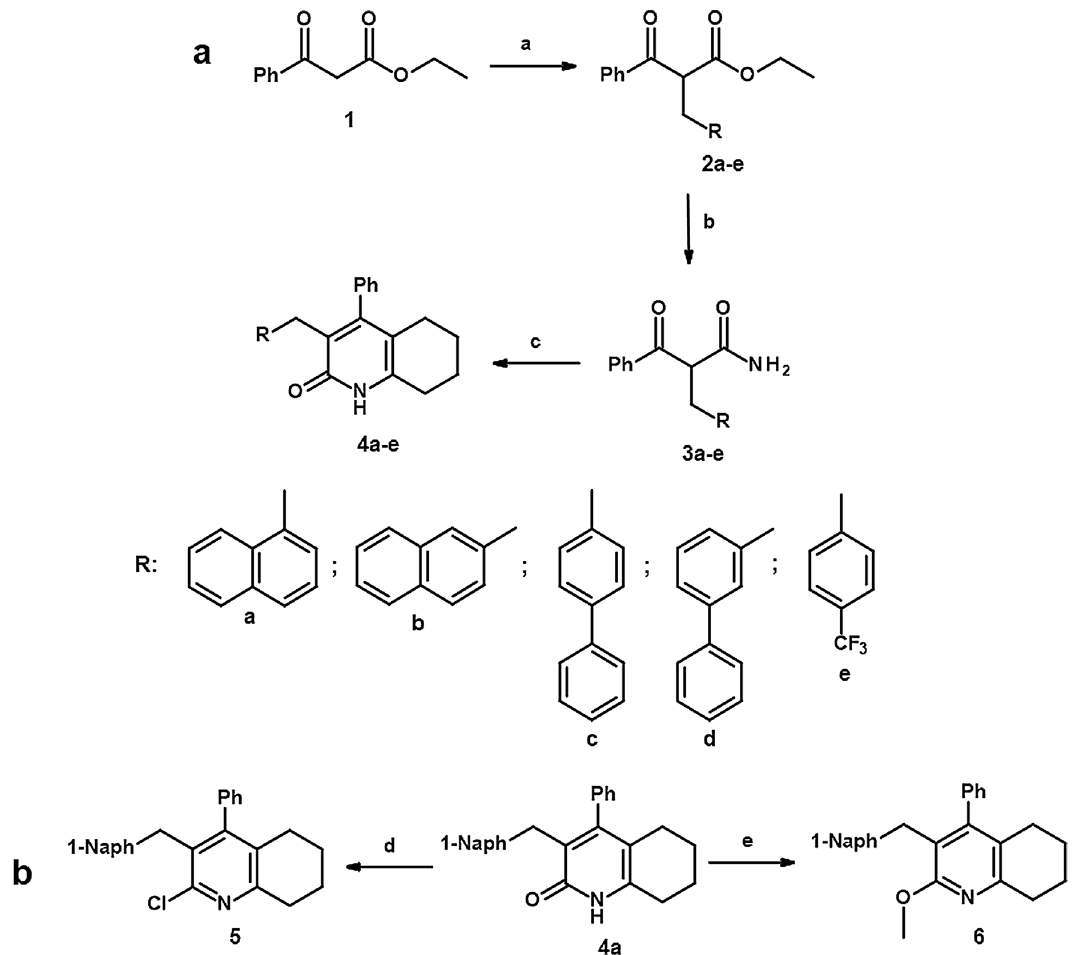
Figure 2. Synthetic pathways for the preparation of new tetrahydroquinolinone derivatives: ( a ) RCH 2 X, K 2 CO 3 /DMF, 60 °C, 5 h; ( b ) 24% NH 3 aq , 50 °C, 24–72 h; ( c ) TsOH/toluene, reflux, 12 h; ( d ) PhP(O)Cl 2 , 160 °C, 16 h; ( e ) Ag 2 CO 3 , CH 3 I/CHCl 3 , RT, 12 h.